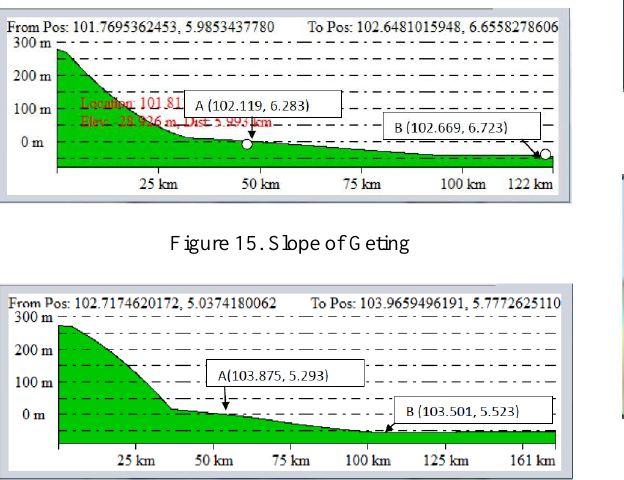
Figure 16. Slope of Cendering